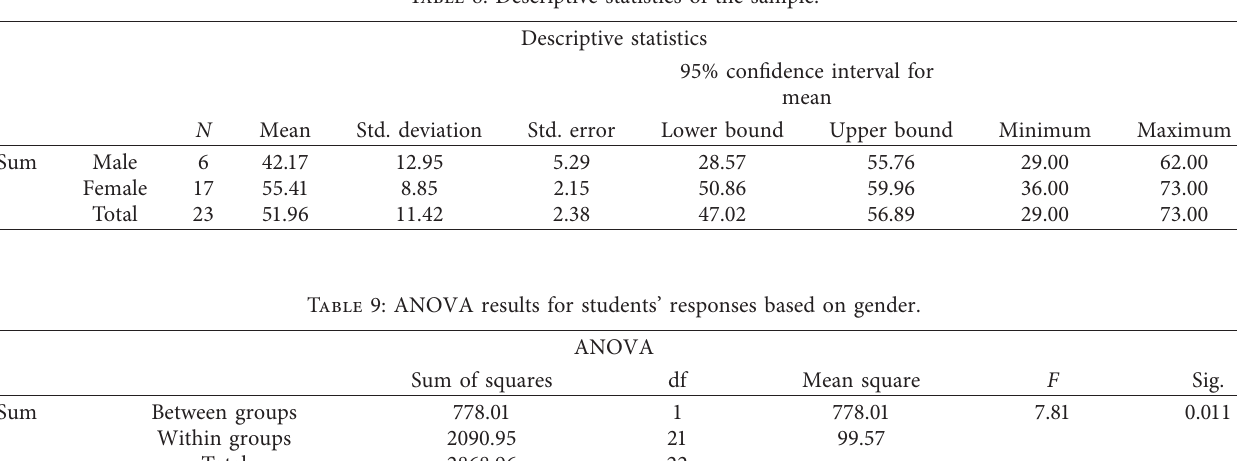
Table 8: Descriptive statistics of the sample.